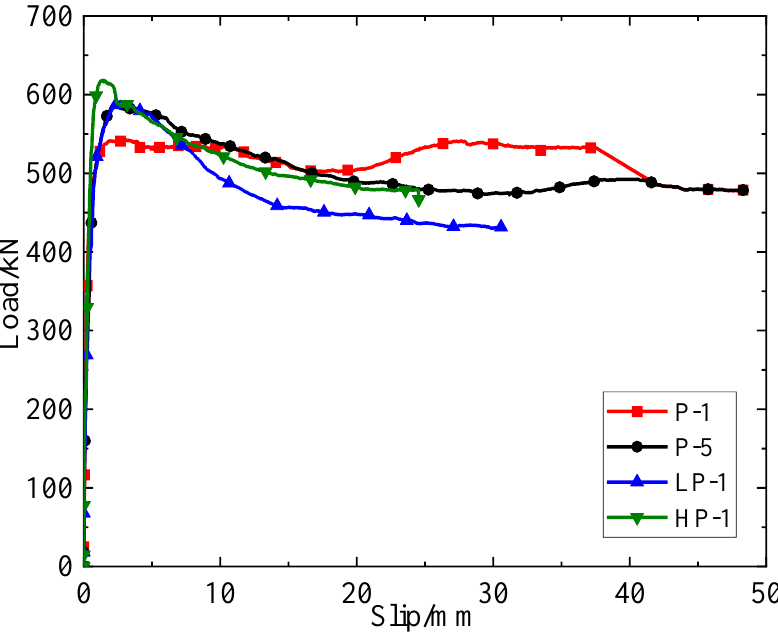
Figure 15. Effect of stirrup form on load – slip curves.